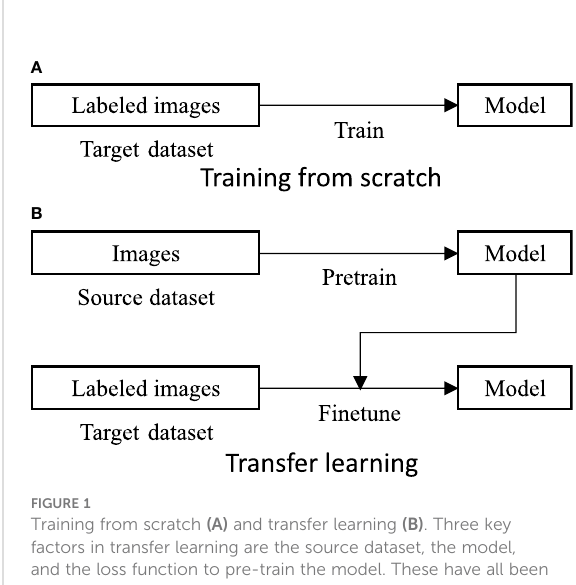
FIGURE 1 Training from scratch (A) and transfer learning (B) . Three key factors in transfer learning are the source dataset, the model, and the loss function to pre-train the model. These have all been undeveloped in plant disease